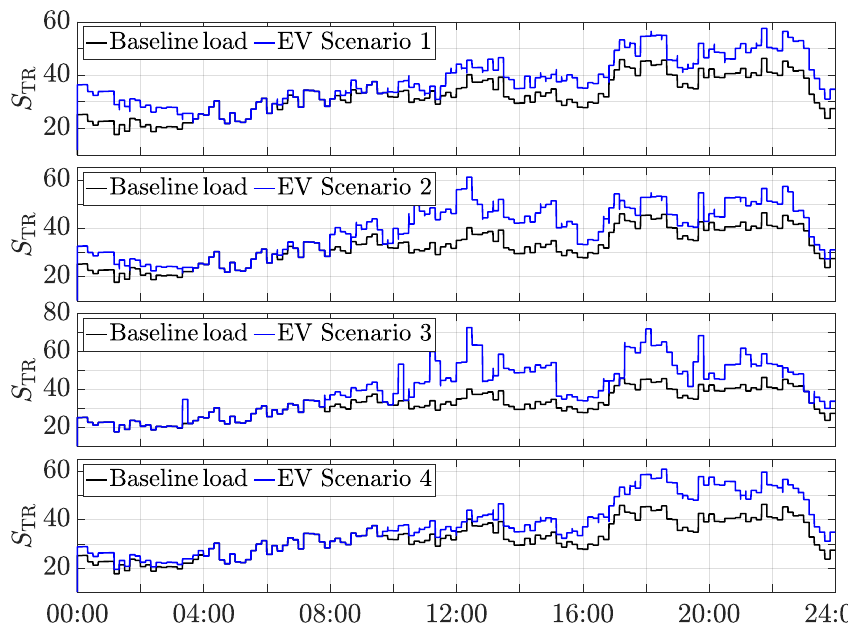
Figure 2. Transformer loading under different EV charging scenarios ( S TR in